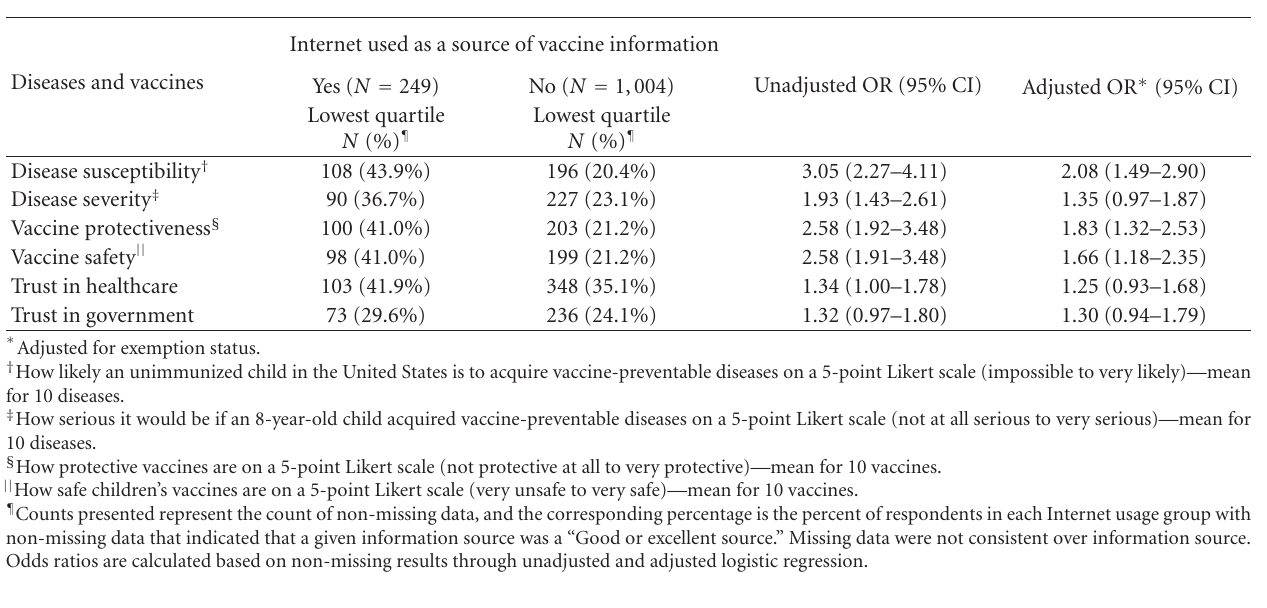
Table 4: Association of disease, vaccine, and trust constructs with Internet use as a source of vaccine information among parents of school aged